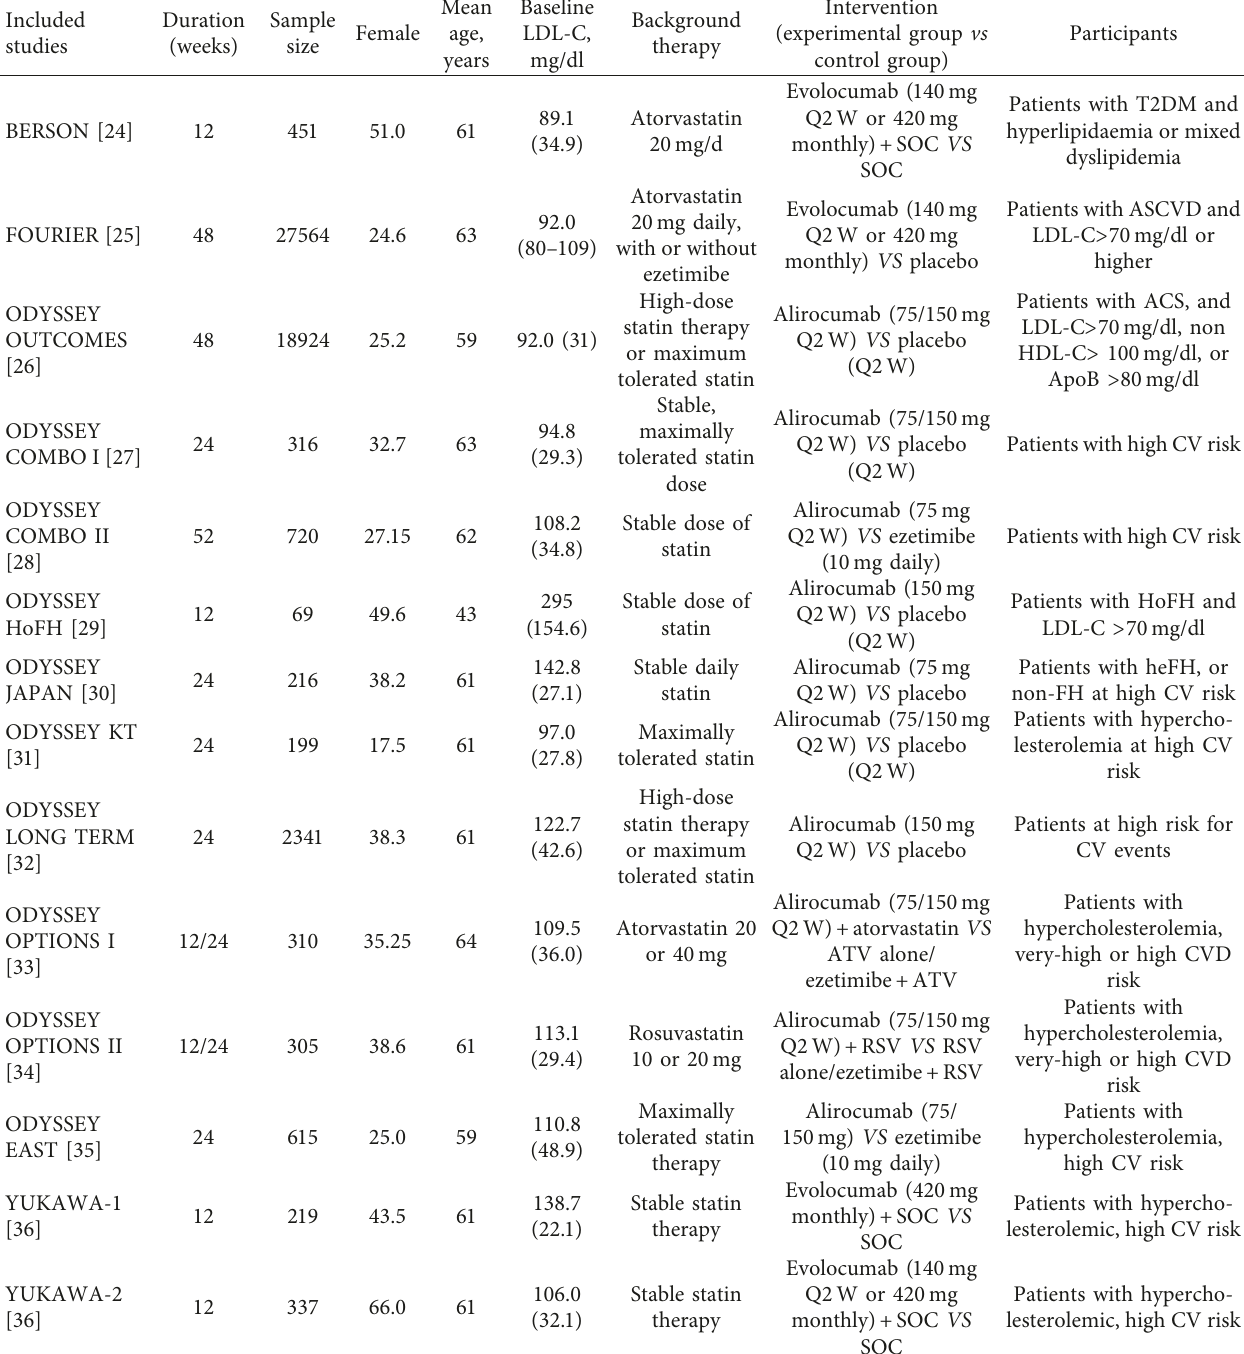
Table 1: Characteristics of the 14 trials identified in the literature